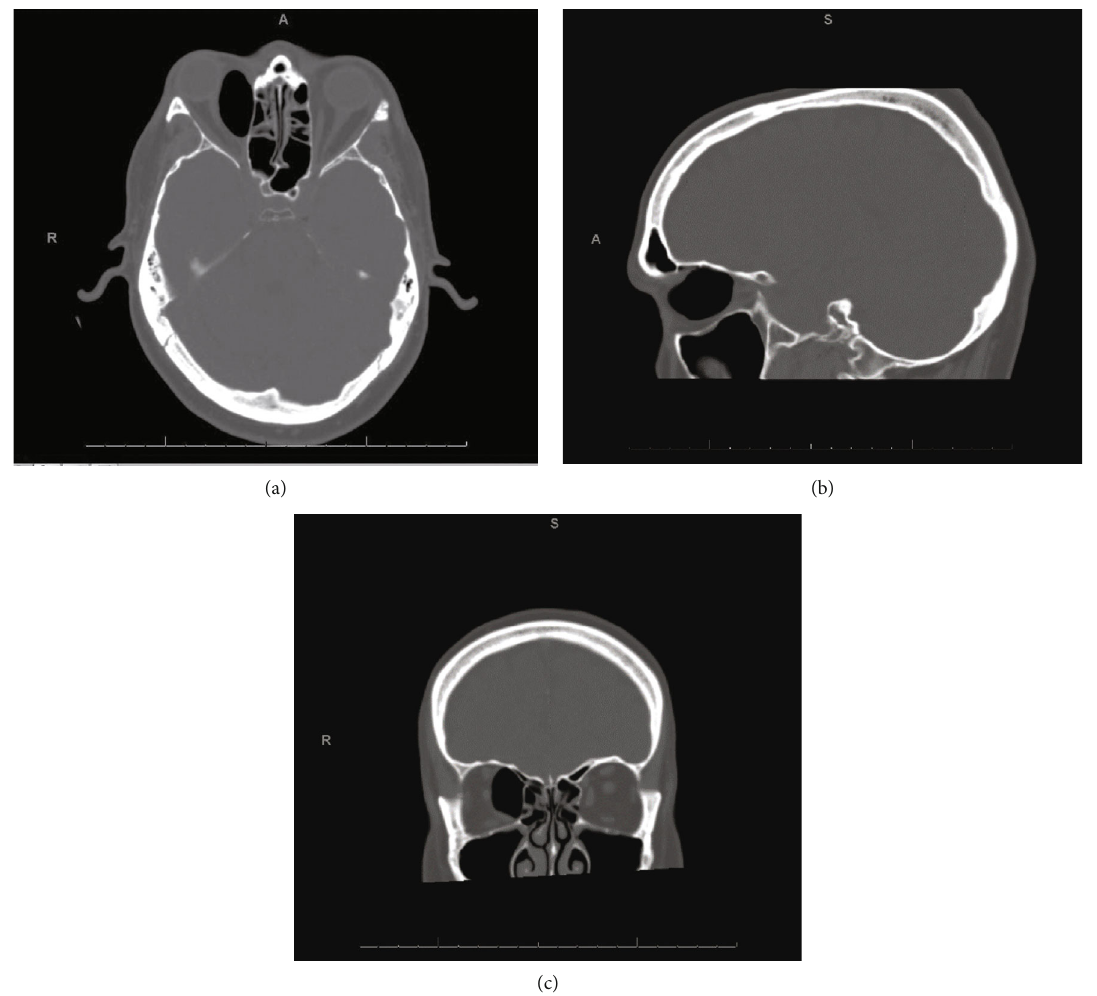
Figure 1: CT scan of patient with (a) axial, (b) sagittal, and (c) coronal views showing a 36 × 26 × 16 mm collection of gas in the medial aspect of right orbit causing displacement of intraorbital structures and